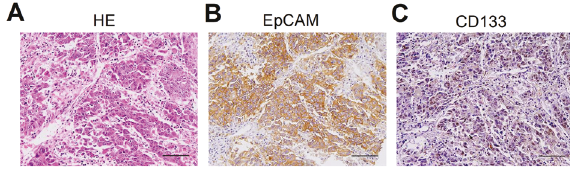
Fig. 2 c-MYC -induced HCC has strong cancer stemness properties. c-MYC -induced HCC sections were subjected to A HE and B , C immunohistochemical staining. HE